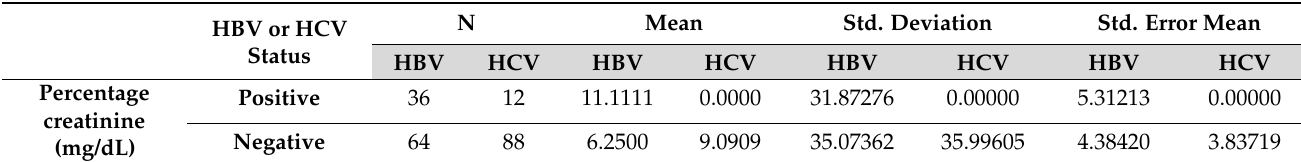
Table 4. Group statistic table for renal function.